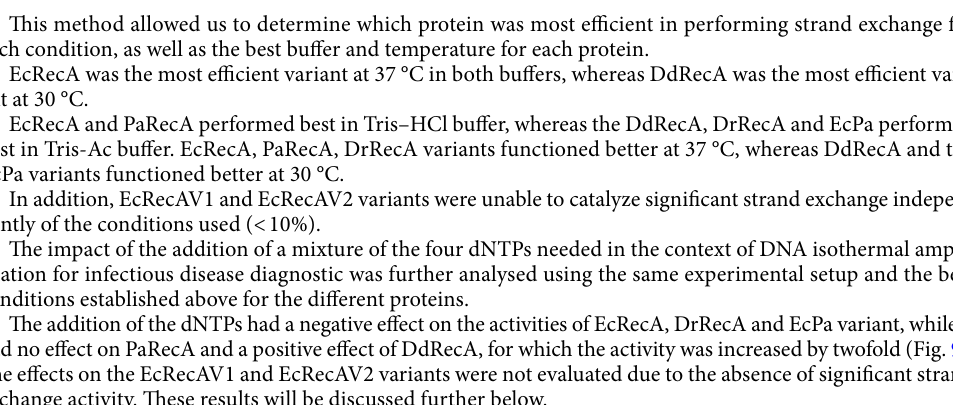
Figure 6. Activation of the SOS response by RecA variants. (A) The scheme represents the SOS response in E. coli : in the absence of DNA damage, the transcription of SOS genes is blocked by LexA repressor. Under conditions of DNA damage, RecA-ssDNA filaments are generated and catalyse the self-cleavage of LexA. SOS genes, including the sulA gene, are then transcribed. ( B) The SOS response was assessed by measuring the specific fluorescence of strains producing RecA variants under 1 mM IPTG induction and a GFP protein expressed under the sulA promoter. Three different biological experiments were performed. The effect of RecA variants in the absence of nalidixic acid is represented in black dot filled bars and the effect of RecA variants in the presence of an inducer of the SOS response, nalidixic acid, at a concentration of 15 µg/mL in red filled bars. The results are presented as histograms. NS indicates a non-significant p-value (from the t test comparing the values of the strains producing RecA variants with those of the strain producing no RecA), * indicates a significant p-value < 0.05 and ** a significant p-value < 0.005. Error-bars indicates